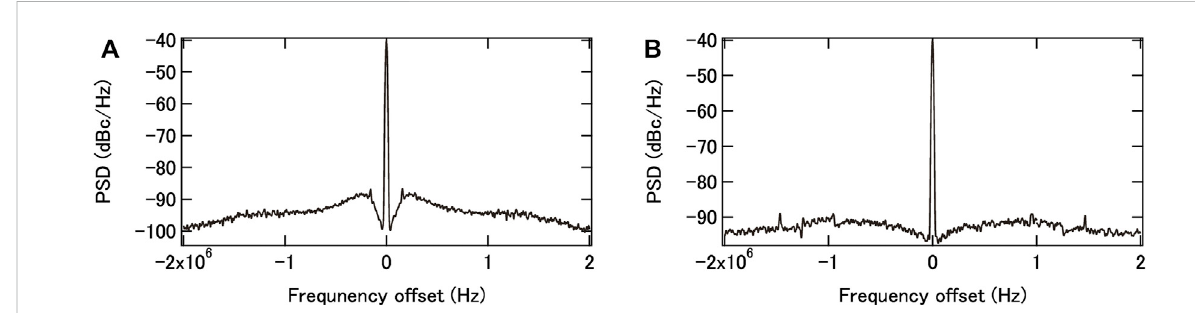
RFspectraofphase-locked (A) f ceo and (B) f beat inanultra-low-noiseall-PMEr-doped fi bercombusingaNALM(fromref.9).PSD=phasenoise spectral